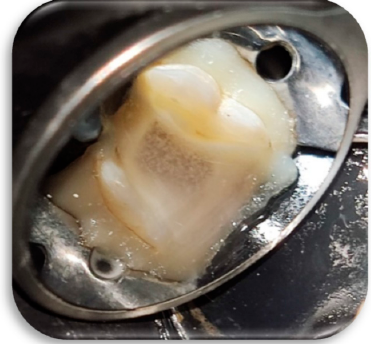
Figure 3. Pulp chamber after activation of hypochlorite in root canals.